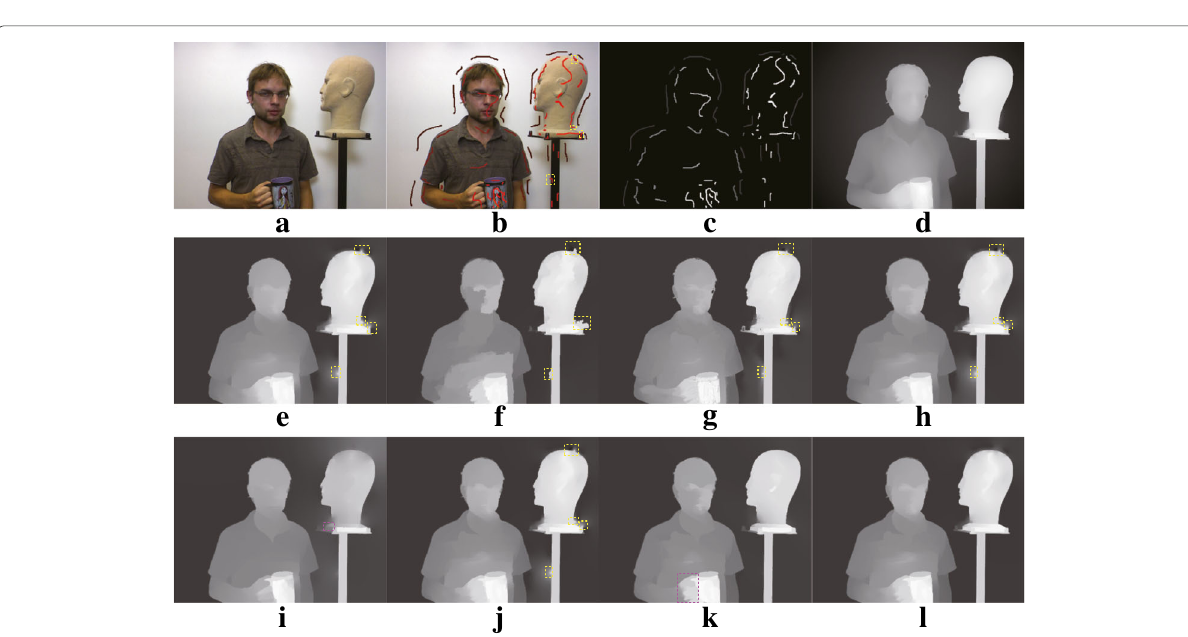
Fig. 9 Results of RGBZ_06 with cross-boundary input. a Input image. b User-labeled image. c Sparse depth. d Groundtruth depth. e Depth of RW. f Depth of HGR. g Depth of NRW. h Depth of OPT. i Depth of OCP. j Depth of SDF. k Depth of (cid:2) 1 . l Depth of the proposed method. Please zoom in to see